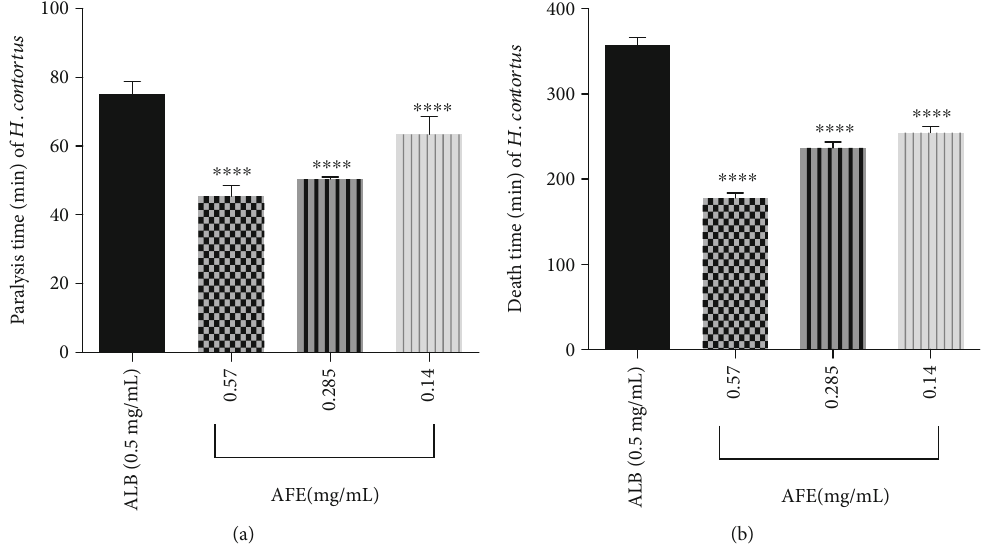
Figure 2: E ff ect of AFE on paralysis and death time of H. contortus. (a) Paralysis time. (b) Death time. ALB: albendazole; n = 9 , values are mean ± SEM ; ∗∗∗∗ p < 0 : 0001 , compared to the control (one-way ANOVA followed by Dunnett ’ s post hoc test). No paralysis was observed after maximum time of exposure (8 hours) in the negative control group (Ringer ’ s lactate